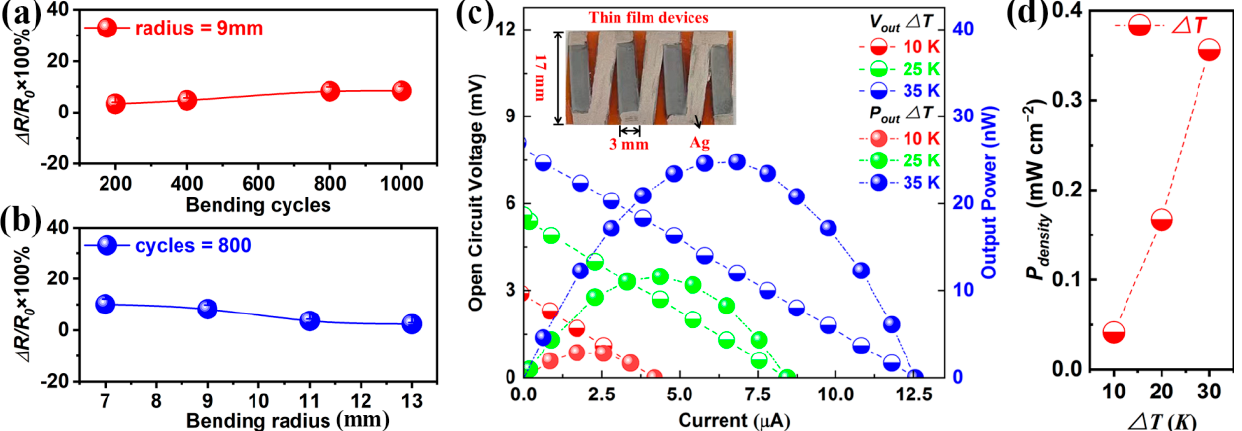
Figure 5. ( a ) The ∆ R / R 0 as a function of bending cycles at bending radius of 9 mm. ( b ) The ∆ R / R 0 as a function of bending radius at bending cycle of 800. ( c ) Open circuit voltage and output power as a function of electric current at different ∆ T . ( d ) The power density as a function of ∆ T .